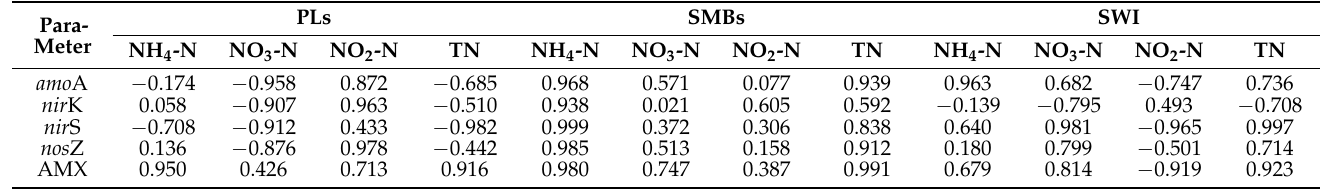
Table 4. Pearson correlation coefficients between nitrogen removal rates and functional genes in different MSL-SWI media. PLs SMBs SWI Para- Meter NH 4